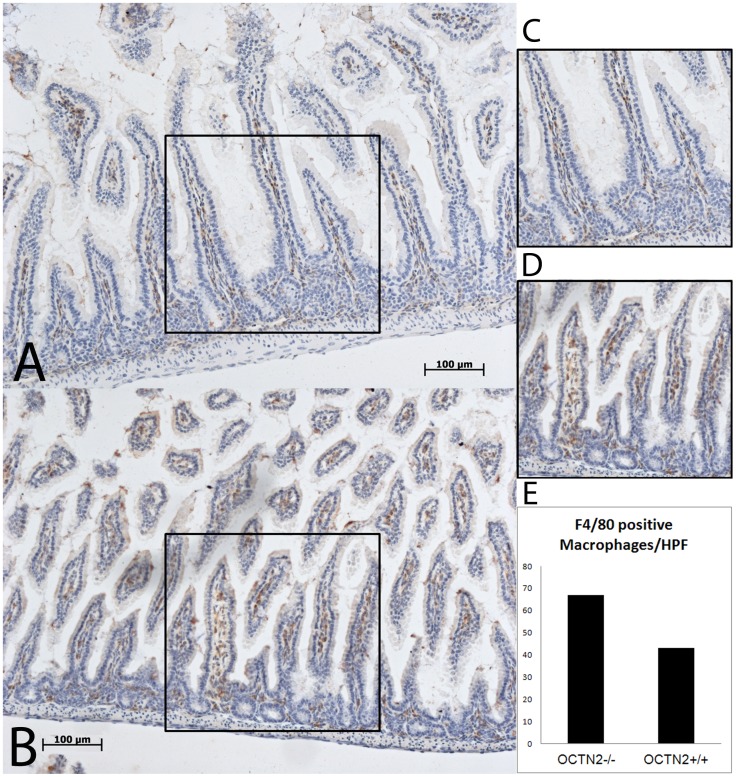
Immunohistochemical analysis of macrophage infiltration in 1-week-old wild type (OCTN2+/+) and homozygous (OCTN2−/−) mice ileum sections.Panel A is an ileum section showing F4/80 staining (brown) of villous macrophages from the wild-type mouse and panel C is a high power magnification of a representative area to help count the number of F4/80 positive cells. Panel B is an ileum section of a homozygous mouse and panel D is a high power magnification of a representative area. Panel E is a graphic representation of the number of F4/80 positive cells in each section (Bar represents 100 µm).